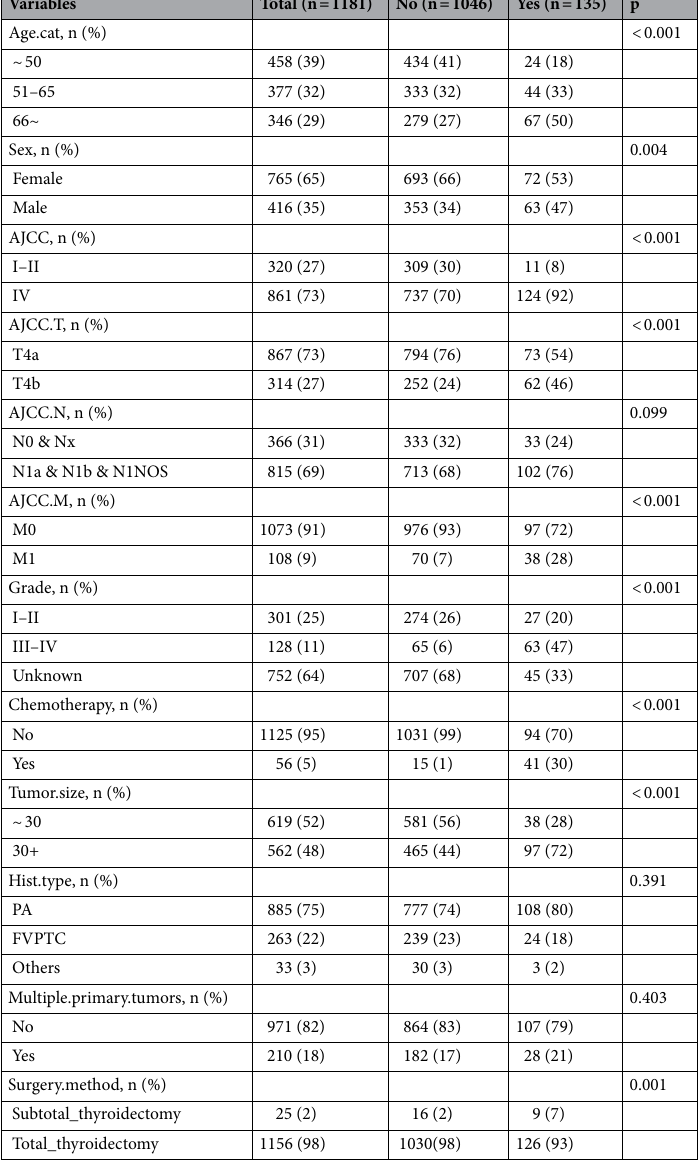
Table 1. Patient characteristics before